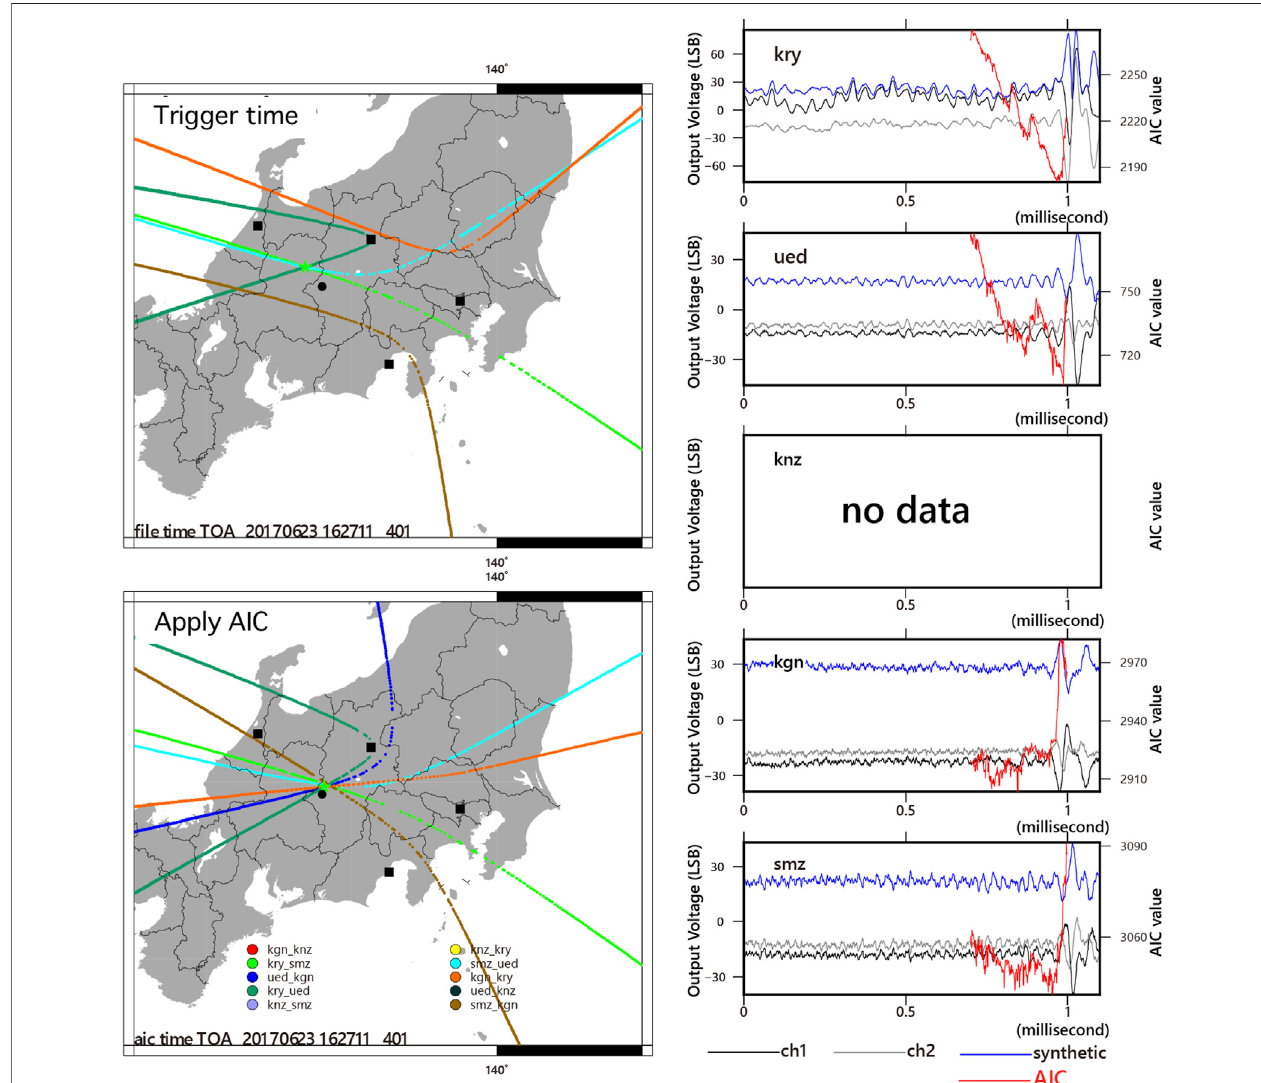
FIGURE3| Exampleofsource location identi fi cation viathetime ofarrival (TOA) method. The triggertime isassumed tobeequaltotheTOAofanelectromagnetic wave(upperleftpanel).Inthiscase, threehyperbolas intersect atonepoint, butotherhyperbolasdonotcontributetotheintersection. TheelectromagneticwaveTOAis thetimeat whichtheAIC isminimized. Allsixhyperbolas intersect atonepoint (lower leftpanel).Itisan equivalentmethodtoestimate thehypocenterbasedon theinitial motion of the seismic wave in seismology. The right panels show the waveform data of kry, ued, knz (no data), kgn, and smz from the top. These waveforms were triggered at the point of 1 ms. The calculated AIC is displayed as a red line. The time when AIC becomes minimum is de fi ned as the TOA of an electromagnetic wave.